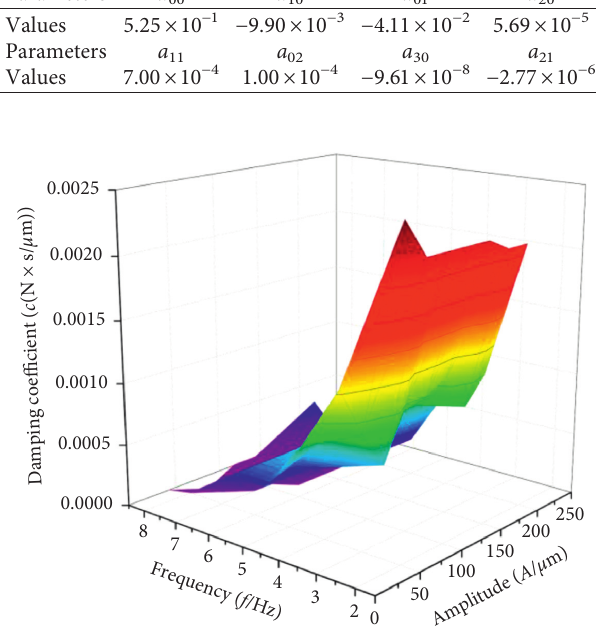
Figure 12: The space surface of damping coefficient c ( A , f ).